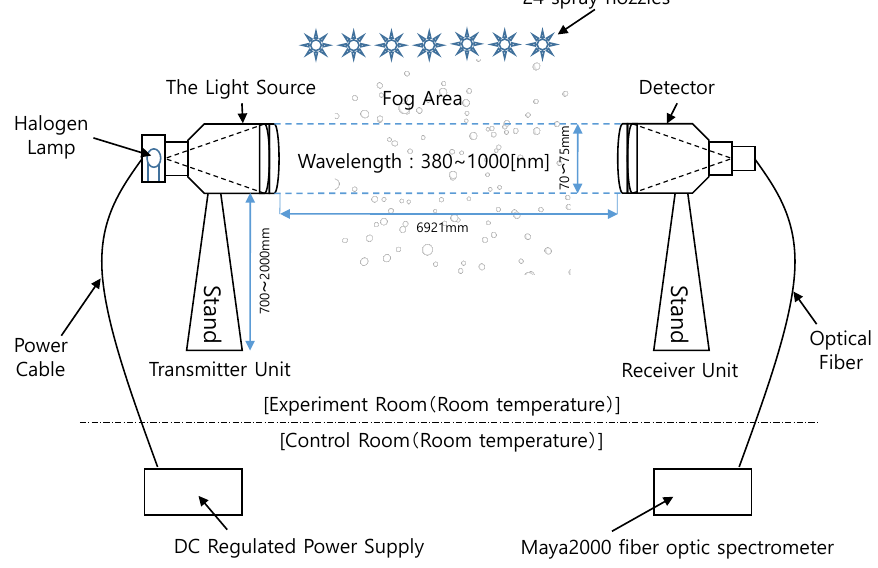
Figure 4. Spectral transmittance measurement using a halogen lamp in the fog chamber.